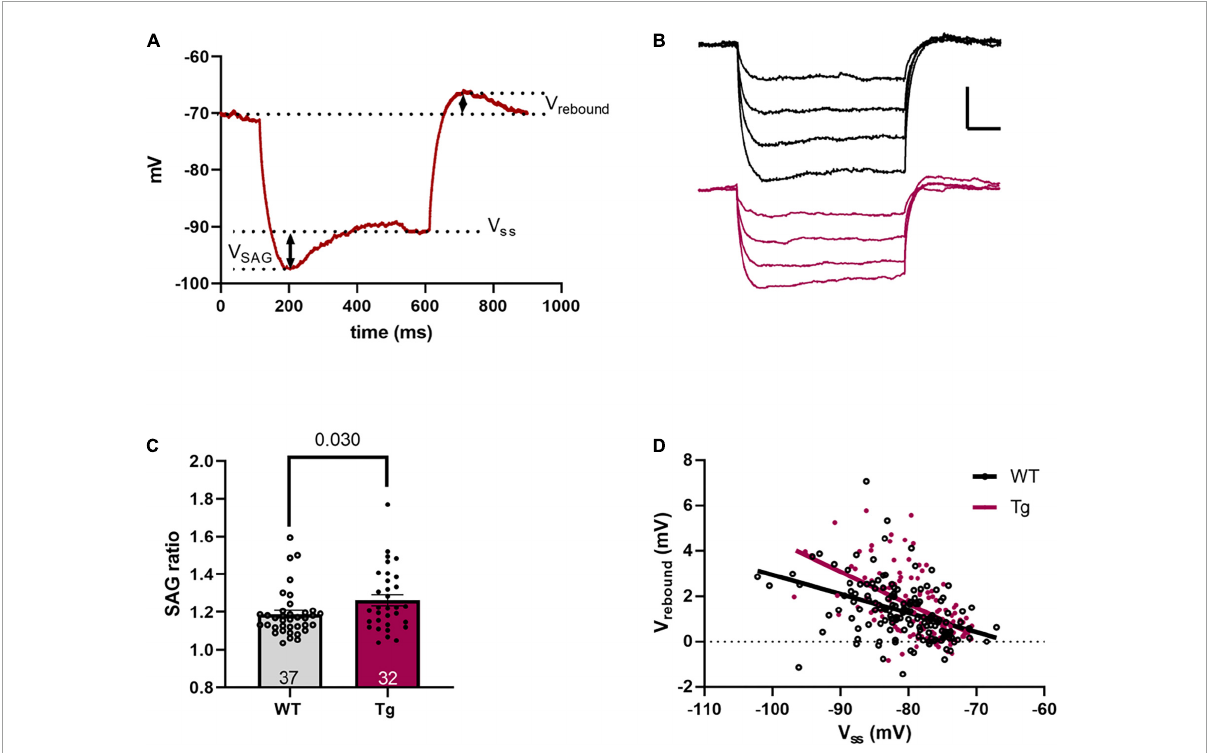
FIGURE3 Sag and rebound are increased in 8-month-old Tg mice. (A) A representative voltage response to a –100 pA hyperpolarizing current step. Measurements of sag voltage (V SAG ), steady-state voltage (V SS ), and rebound voltage (V rebound ) are noted. (B) Representative voltage traces resulting from four hyperpolarizing current steps ( − 100 to − 25 pA). The black trace is a WT and the red trace is a Tg cell. Scale bar is 5 mV/100 ms. (C) The SAG ratio, as defined in the text, is higher in the Tg animals. (D) A plot of V rebound vs. V SS shows a significant difference in slope, indicating a larger slope in the Tg animals.